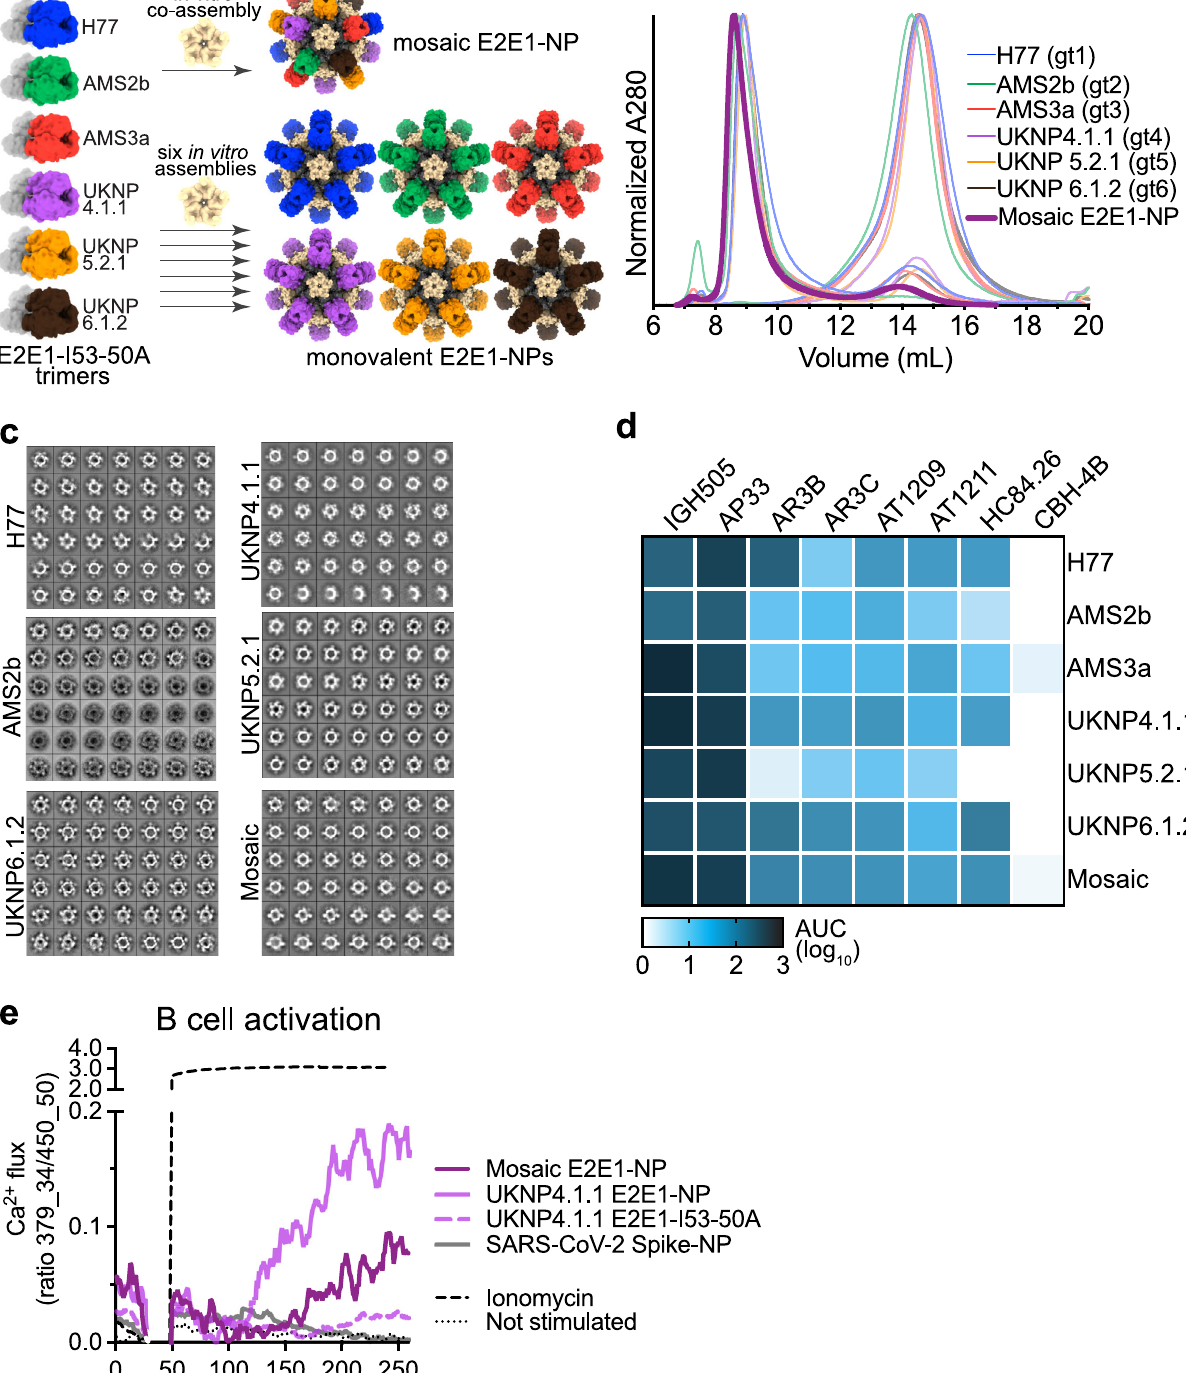
activation by E2E1-I53-50A trimers or E2E1-NPs. Activation was determined by measuring calcium fl ux in Ramos a B cell line harboring the AR3C bNAb. At 30s, E2E1-I53-50A trimers or E2E1-NPs were added and calcium fl ux was measured after 20s. SARS-CoV-2 spike nanoparticle (see ref. 48) and ionomycin were used as negative and positive control, respectively. Source data are provided as a Source data fi